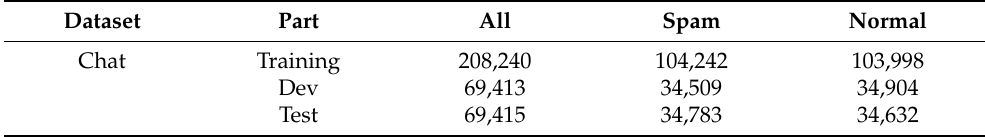
Table 1. Statistics of the Chinese chat spam dataset.